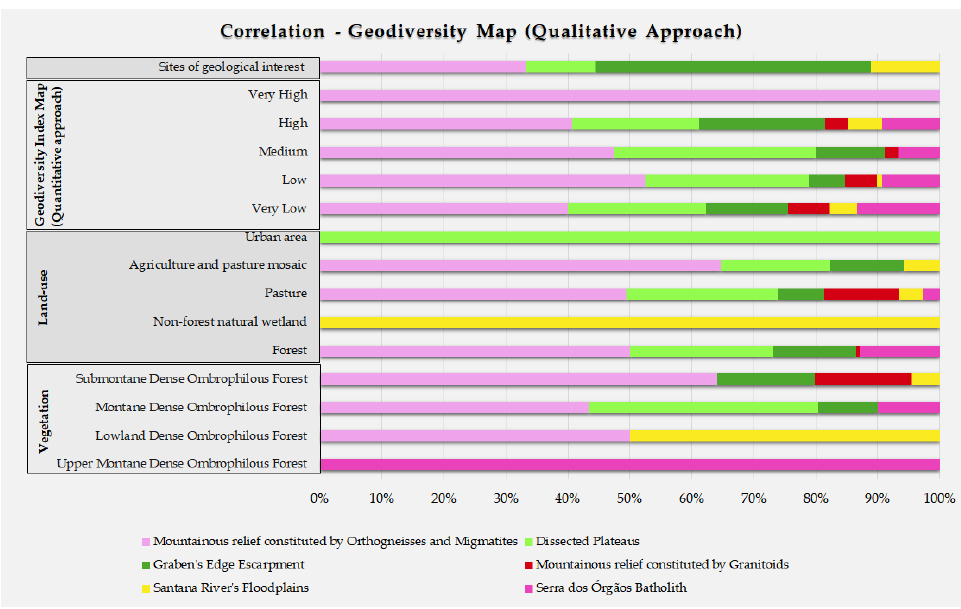
Figure 12. Interpretation of the correlation between the geodiversity units (qualitative approach) and other nature/anthropic elements (sites of geological interest, geodiversity index map, land-use, and vegetation). The bars indicate the percentage of the overlaid features in each geodiversity unit.